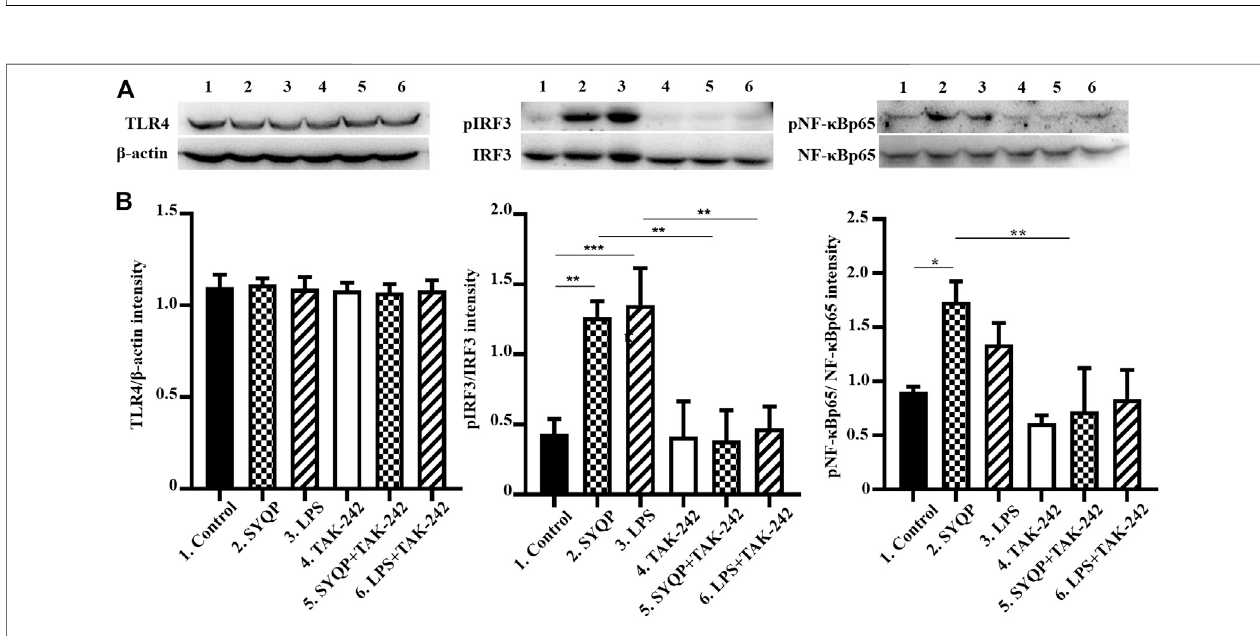
FIGURE 5 | TAK-242 inhibited the phosphorylation of pIRF3 and pNF- κ Bp65 induced by SYQP. The RAW264.7 cells were pretreated with TAK-242 20 μ g/ml for 30 min; then, SYQP 100 μ g/ml or LPS 1 μ g/ml were added into the cell supernatant alone or combined with TAK-242 for another 2 h. The cell lysates were analyzed by westernblot. (A) TheproteinexpressionofTLR4,pIRF3,IRF3,NF- κ Bp65,andpNF- κ Bp65. (B) Densitometricanalysisoftheproteinexpression.Thedataarepresented as the mean ± SD from three independent experiments.